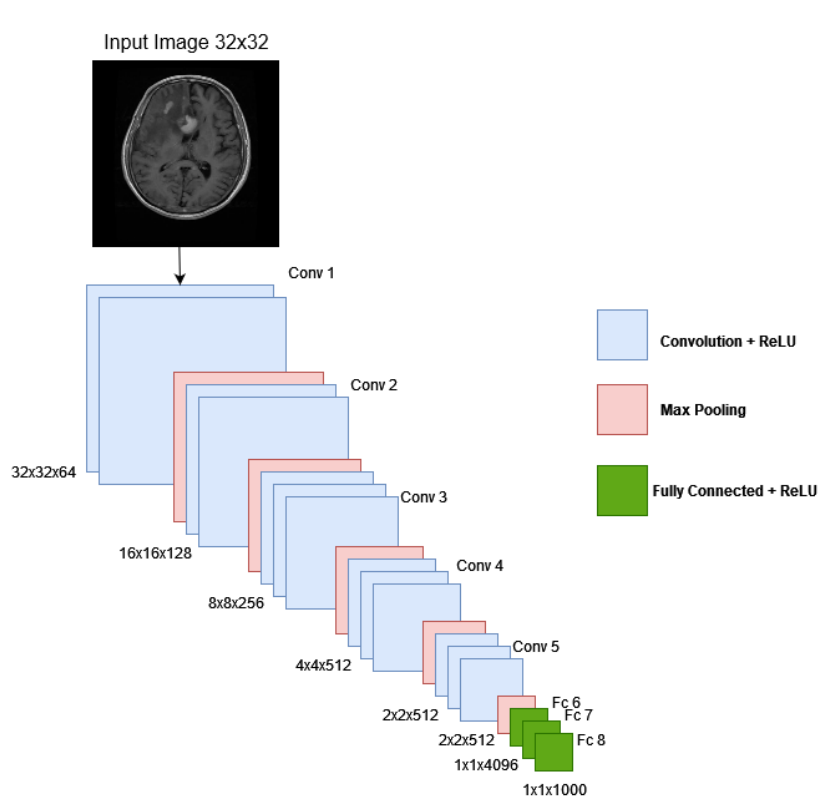
Figure 6. Architecture of VGG16.